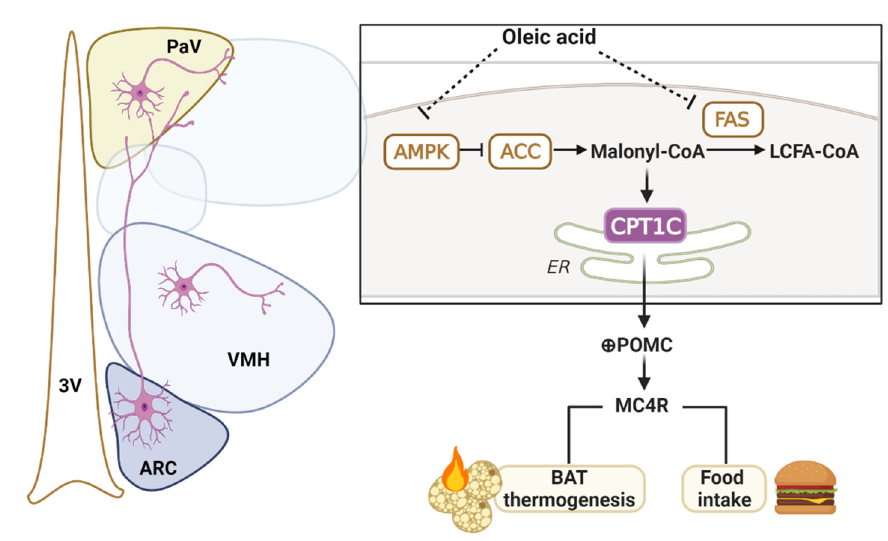
Figure 8. Central infusion of the unsaturated LCFA oleic acid, but not saturated LCFA, induced BAT thermogenesis and attenuate food intake, resulting in body weight loss. This action of oleic acid on BAT thermogenesis involves changes in AMPK/ACC/Malonyl ‐ CoA and FAS in the hypothalamus, which is sensed by CPT1C to in turn drive melanocortin system activation in specific nuclei of the hypothalamus. ARC: arcuate nucleus of the hypothalamus; BAT: brown adipose tissue; FAS: fatty acid synthase; LCFA: long ‐ chain fatty acid; PaV: paraventricular hypothalamus; VMH: ventromedial hypothalamus.